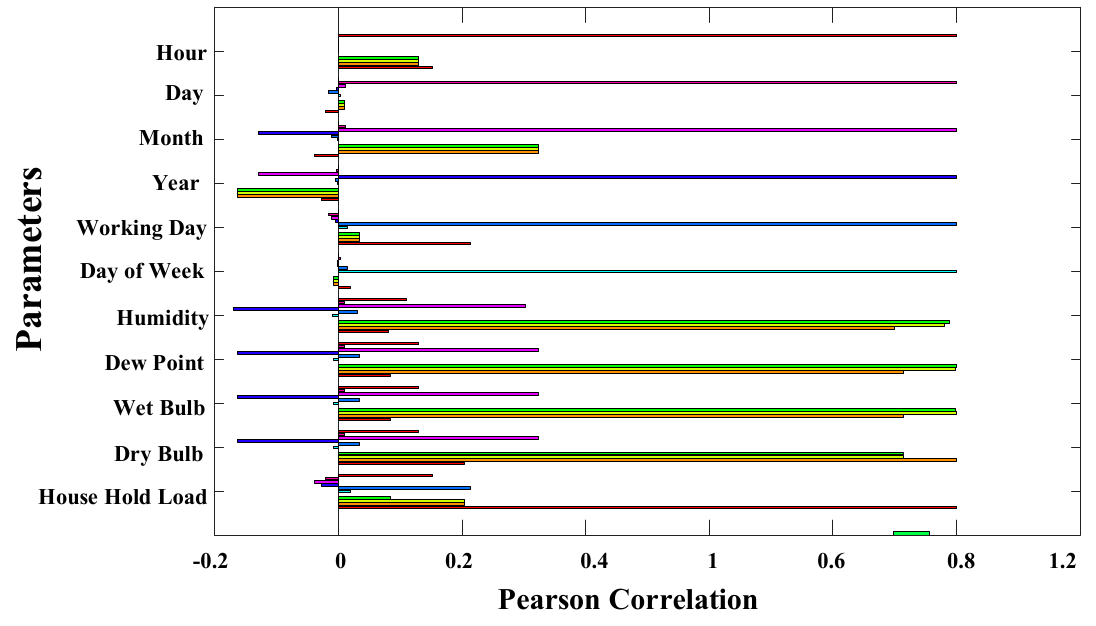
Figure 3. Pearson correlation of input parameters.